Question: What form of chart is displayed?
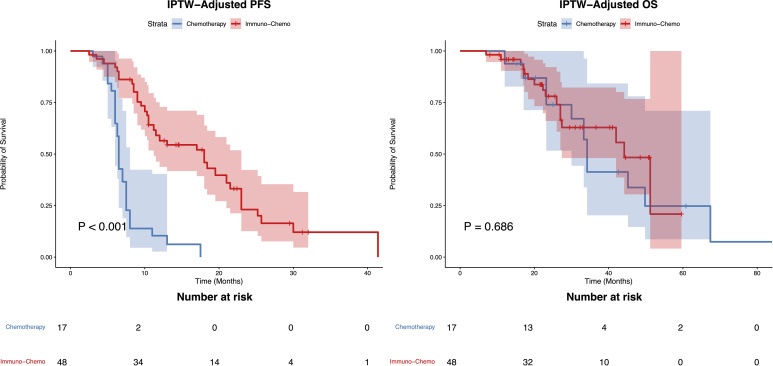
Answer: survival